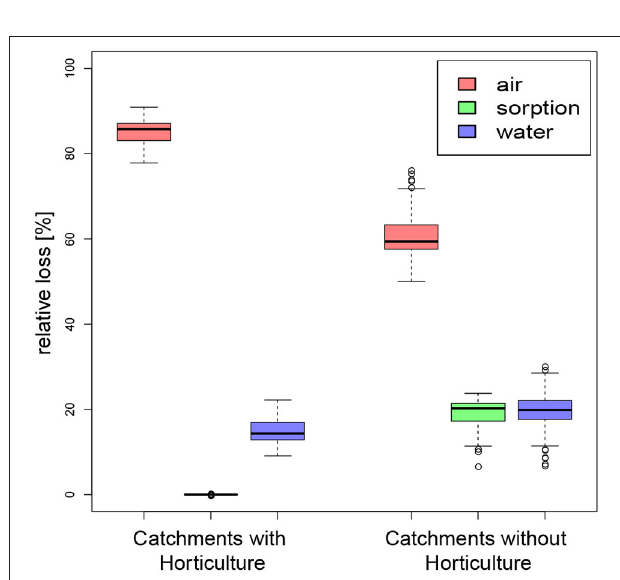
FIGURE 7 | Relative losses of nitrogen into air, water, or retardation from catchments with and without horticulture, indicating a larger importance of volatilization and denitrification (losses into air) for catchments with horticulture than for pristine